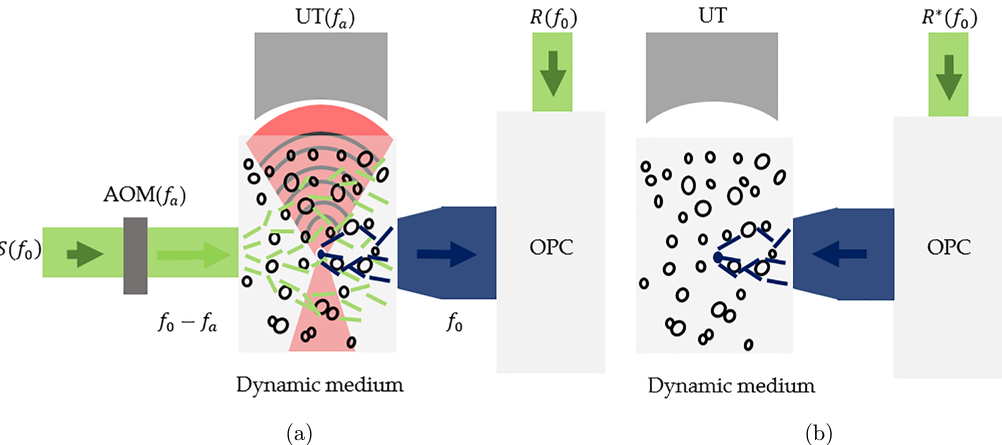
Fig. 2. Principle of TRUE. (a) Recording step. The sample beam S ð f 0 Þ is ¯rst turned to a frequency of f 0 (cid:2) f a by AOM ( f a ) before entering the scattering medium, and S ð f 0 (cid:2) f a Þ is modulated by the ultrasonic wave ( f a ) and changed to be S ð f 0 Þ or S ð f 0 (cid:2) 2 f a Þ . These modulated photons are regarded to be emitted from a virtual optical source (the ultrasonic focus) namely guidestar and exit from the scattering medium. Only ultrasound encoded scattered light S ð f 0 Þ interferes with the reference beam R ð f 0 Þ to realize the phase conjugate recording process. (b) Playback step. The phase conjugated wavefront is time-reversed to achieve light focusing at the ultrasonic